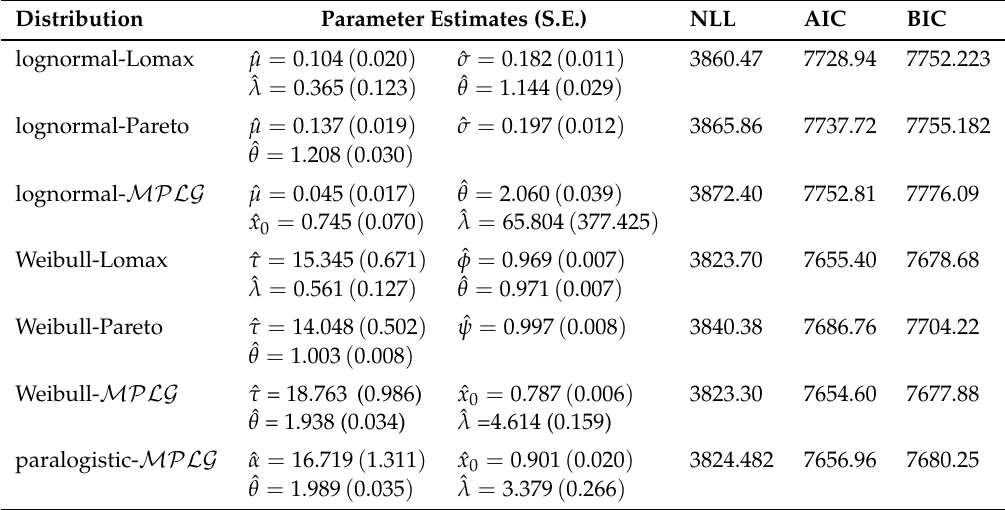
Table 2. Estimated values of different heavy-tailed models, corresponding standard errors (S.E.), NLL, AIC, and BIC of different composite models for the Danish fire losses dataset.